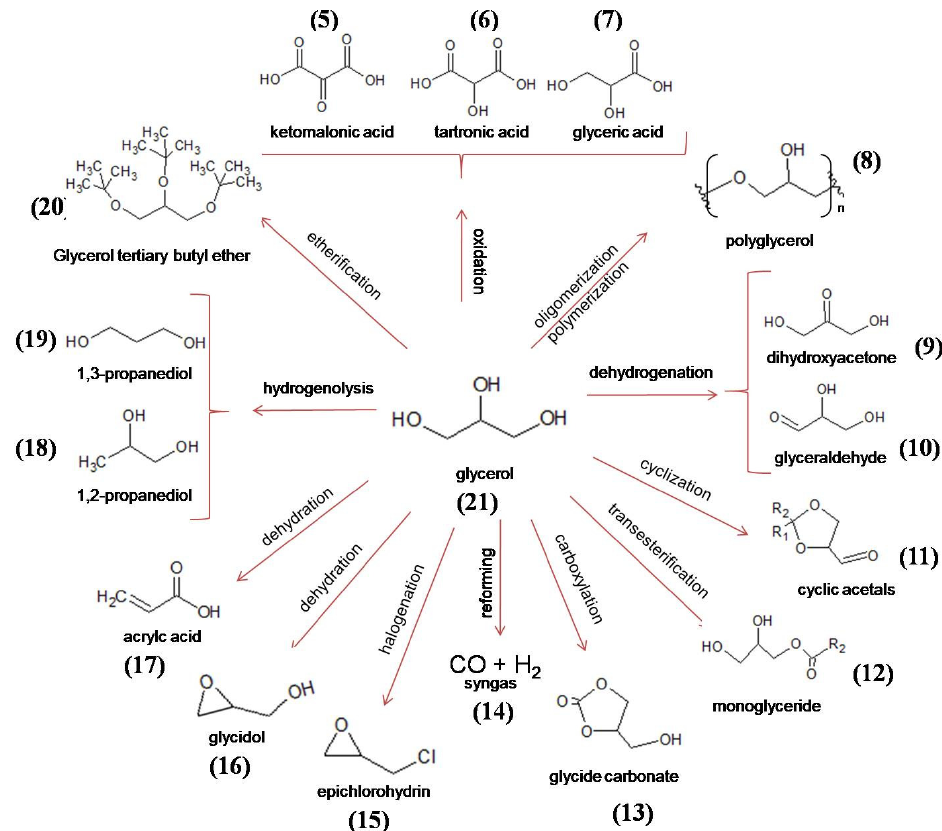
Figure 3. Routes for transforming glycerol into various value-added